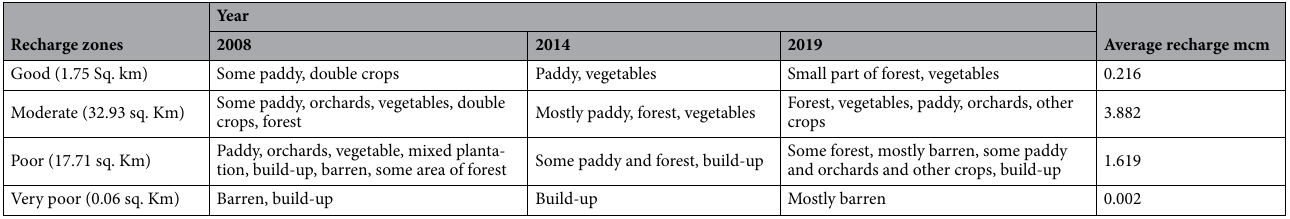
Table 2. Land use land cover in different potential recharge